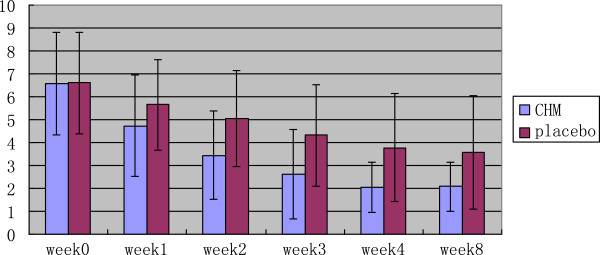
TDS score-change (by gastroenterologists).